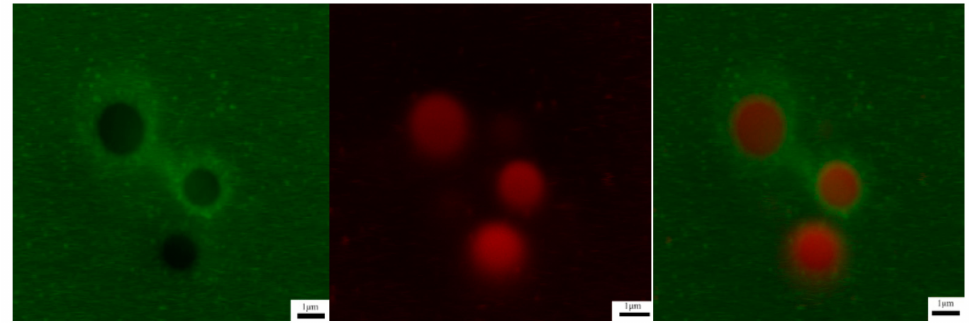
Figure 7. Confocal laser scanning microscopy images of Pickering emulsion of vanilla oil 600 ×